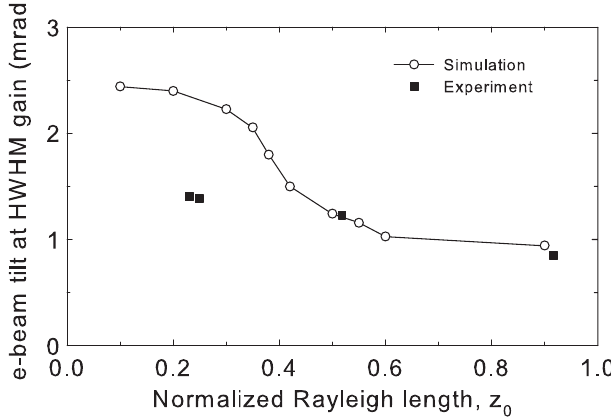
FIG. 8. Electron beam tilt at HWHM gain versus z 0